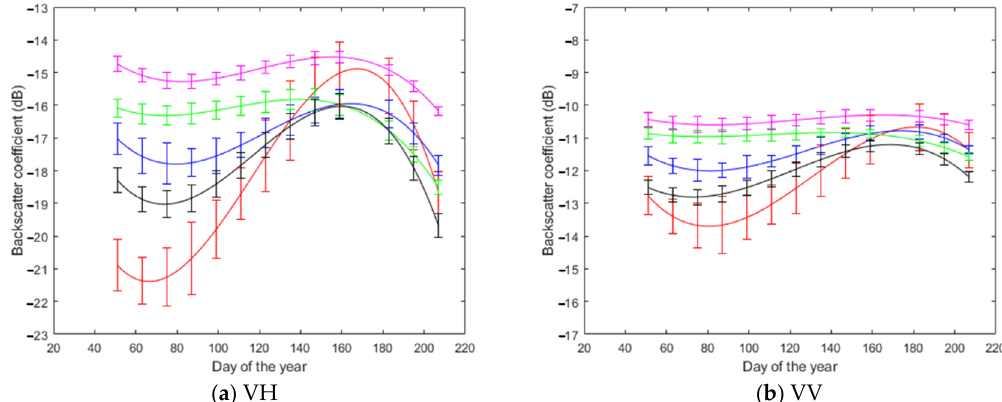
Figure 5. Backscattering curves (with mean and standard deviation bars) of food crops for VH and VV polarizations. Rice is shown in red, maize in blue, peanut in green, wheat in black and onion in magenta.